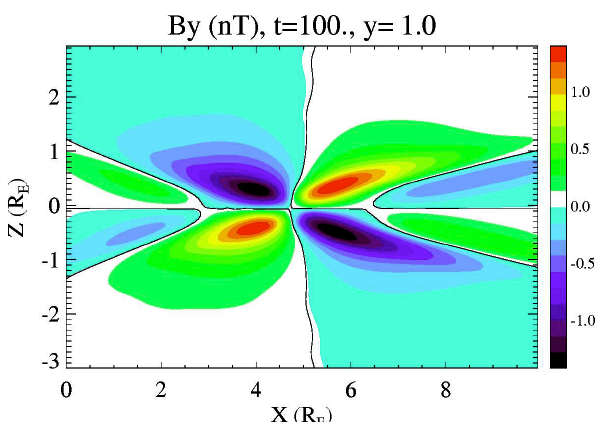
Fig. 7. Contours of the B y component in the y =1 plane. Note the quadrupolar pattern, similar to that found in the Hall reconnection picture. However, this differs since the polarity of the field is re- versed for negative values of y